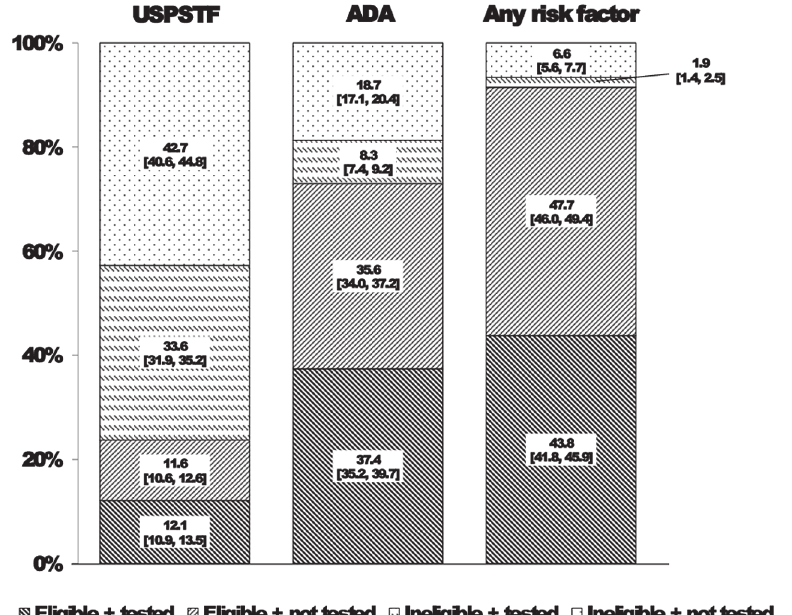
Fig 1. Percentage of US adults reporting receipt of glucose testing by eligibility status according to diabetes screening guidelines. Abbreviations: USPSTF, United States Preventive Services Task Force; ADA, American Diabetes Association. Data were from 5,813 adults without diagnosed diabetes in the 2007 – 2012 National Health and Nutrition Examination Survey. Receipt of glucose testing was defined as an affirmative answer to the question, “ Have you had a blood test for high blood sugar or diabetes within the past three years? ” Any risk factor is defined as: age (cid:1) 45 years, body mass index (cid:1) 25 kg/m2, family history of diabetes, high-risk ethnicity, history of gestational diabetes or prediabetes, or blood pressure (cid:1) 140/90 mmHg.